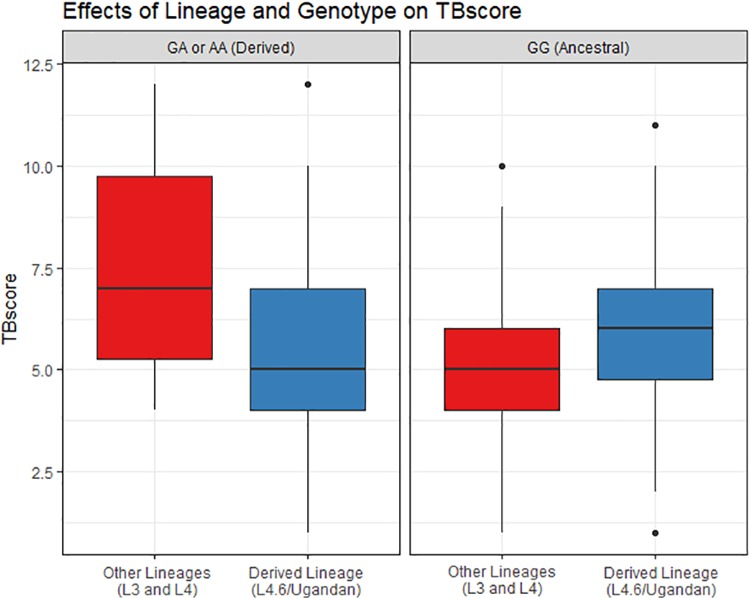
Effects of rs17235409 (SLC11A1) genotype and lineage on TBscore.The association of TB severity with lineage differs but only when stratified by genotype. TBscore is smaller in the Uganda lineage for individuals carrying a derived allele (GA or AA)(left panel) at SLC11A1 but larger for the ancestral genotype (GG) carriers (right panel). These results show the underlying bases of the significant interaction between rs17235409 and MTB lineage (p = 0.00022) with genotype and lineage effect directions differing when examining stratified data.